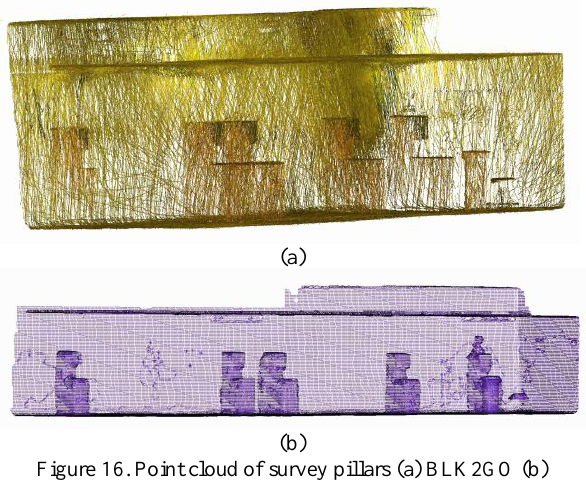
Figure 16. Point cloud of survey pillars (a) BLK2GO (b) Matterport